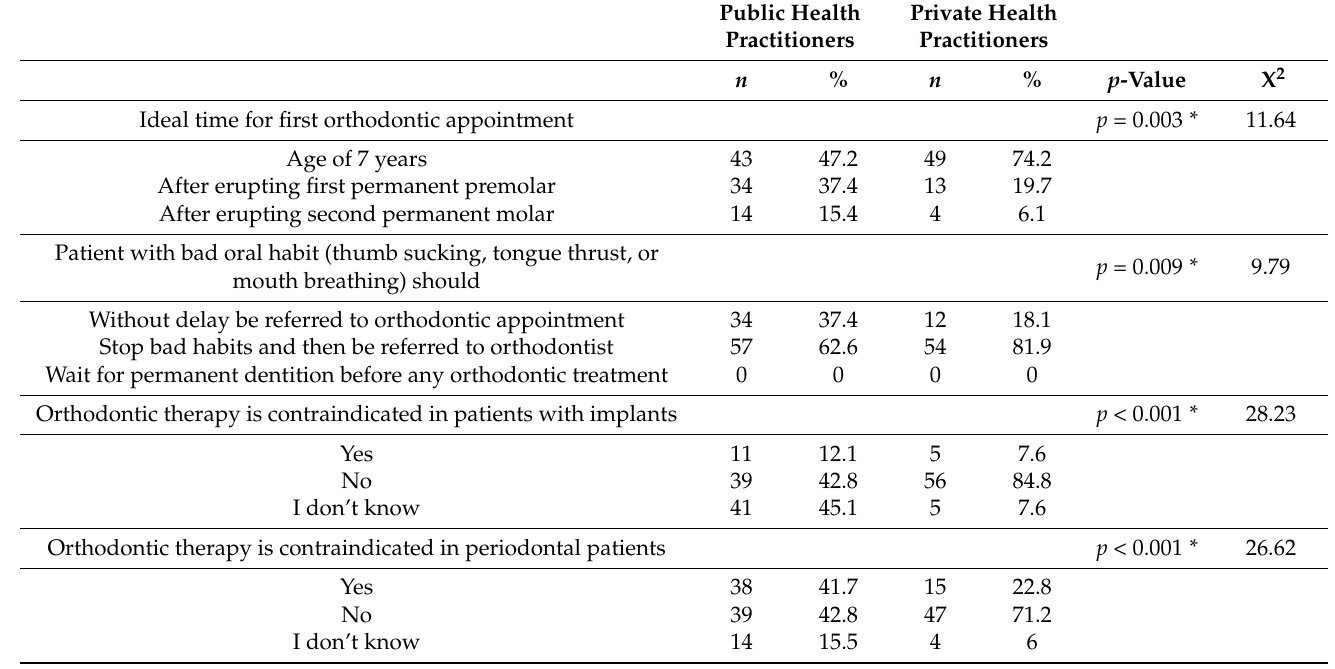
Table 4. Comparison of answers of public health and private health